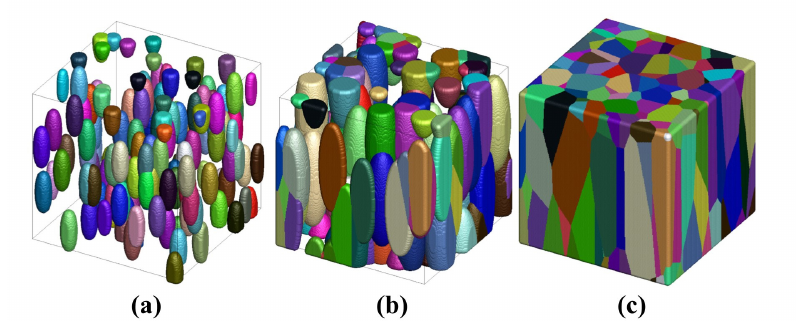
Figure 2. Microstructure of prolate ellipsoids nucleated on 20 random parallel planes with 20 random nuclei on each plane. The nucleation was site-saturated. That is, all nuclei started to grow at the time origin: t 0 = . The ratio of the length of the shorter axes of the ellipsoid the length longer axis to is 4:4:1. Each figure depicts the microstructure corresponding to a progressively higher fraction transformed, V V : a)